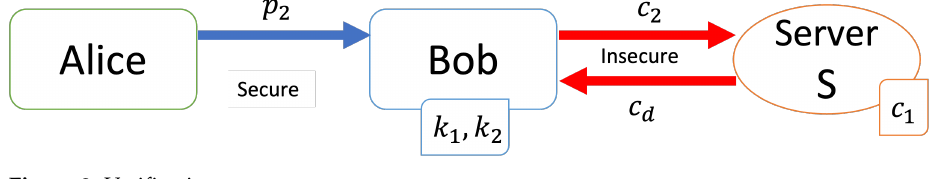
Figure 2. Verification